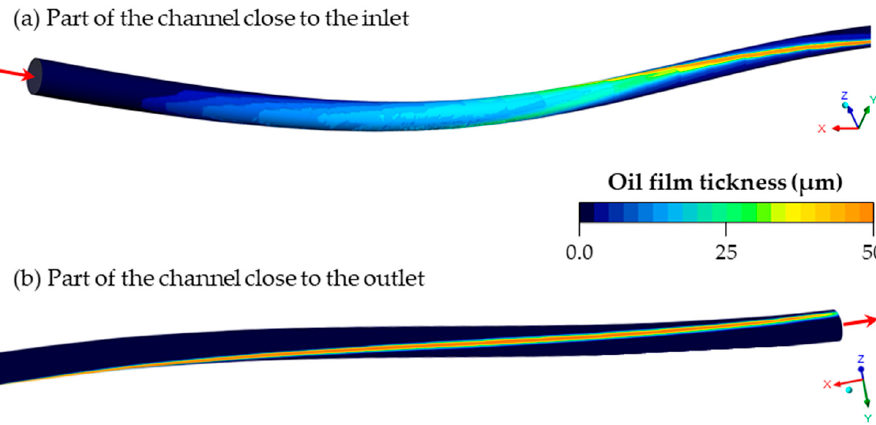
Figure 8. Color plot of the film thickness: Ω = 0 rpm, d = 5 µm, Q = 20 mL/h plotted at different regions of the microchannel: ( a ) close to the inlet and ( b ) close to the outlet. The red arrow indicates the flow direction ( a ) at the microchannel inlet and ( b ) at the microchannel outlet.